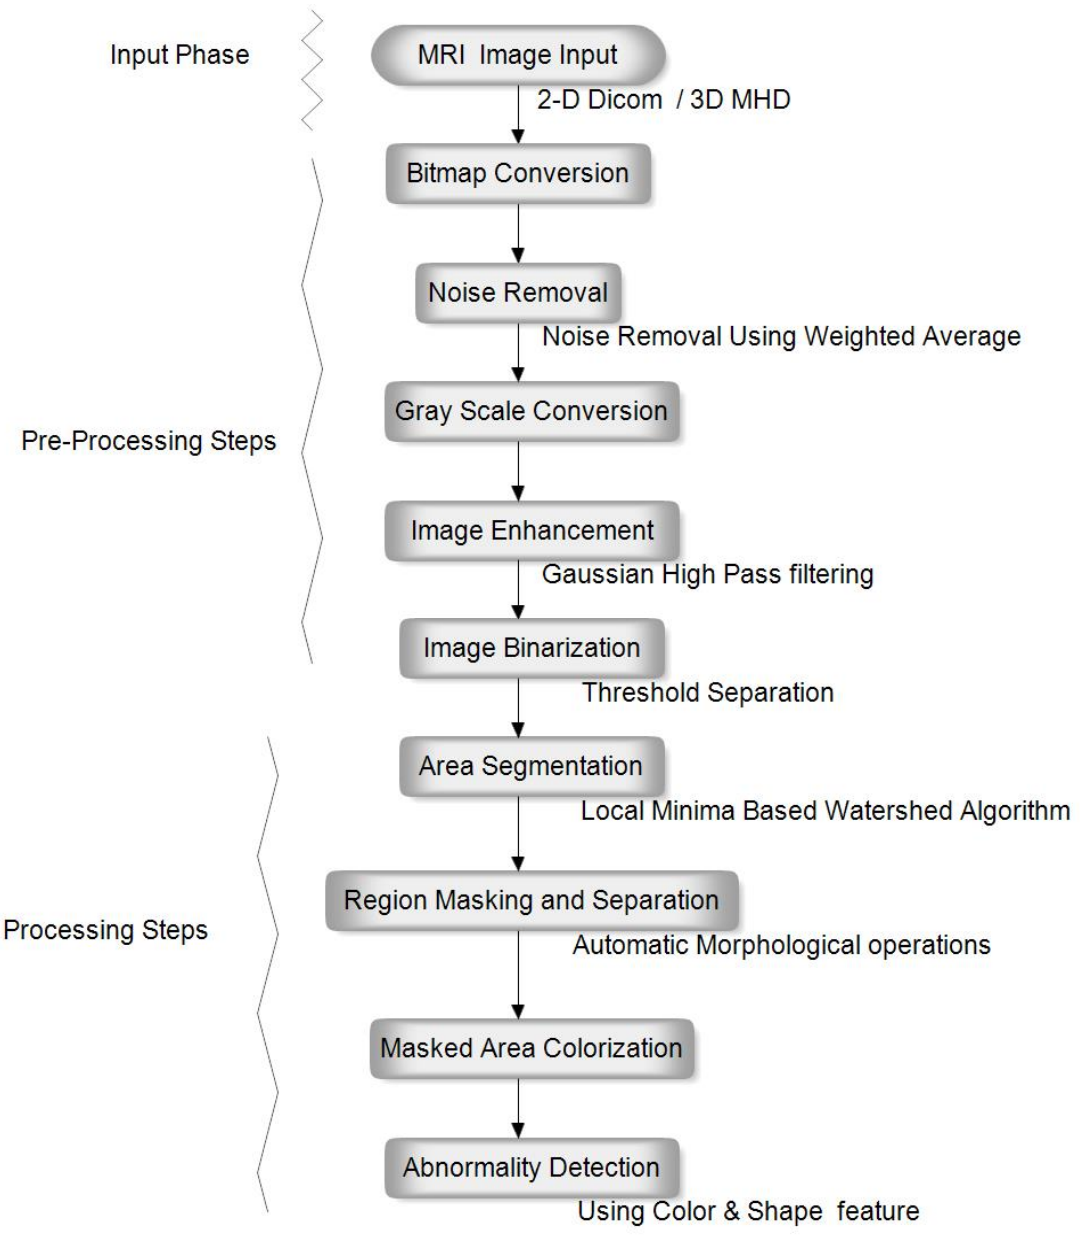
Figure 3. Proposed step-by-step methodology of grayscale image colorization .